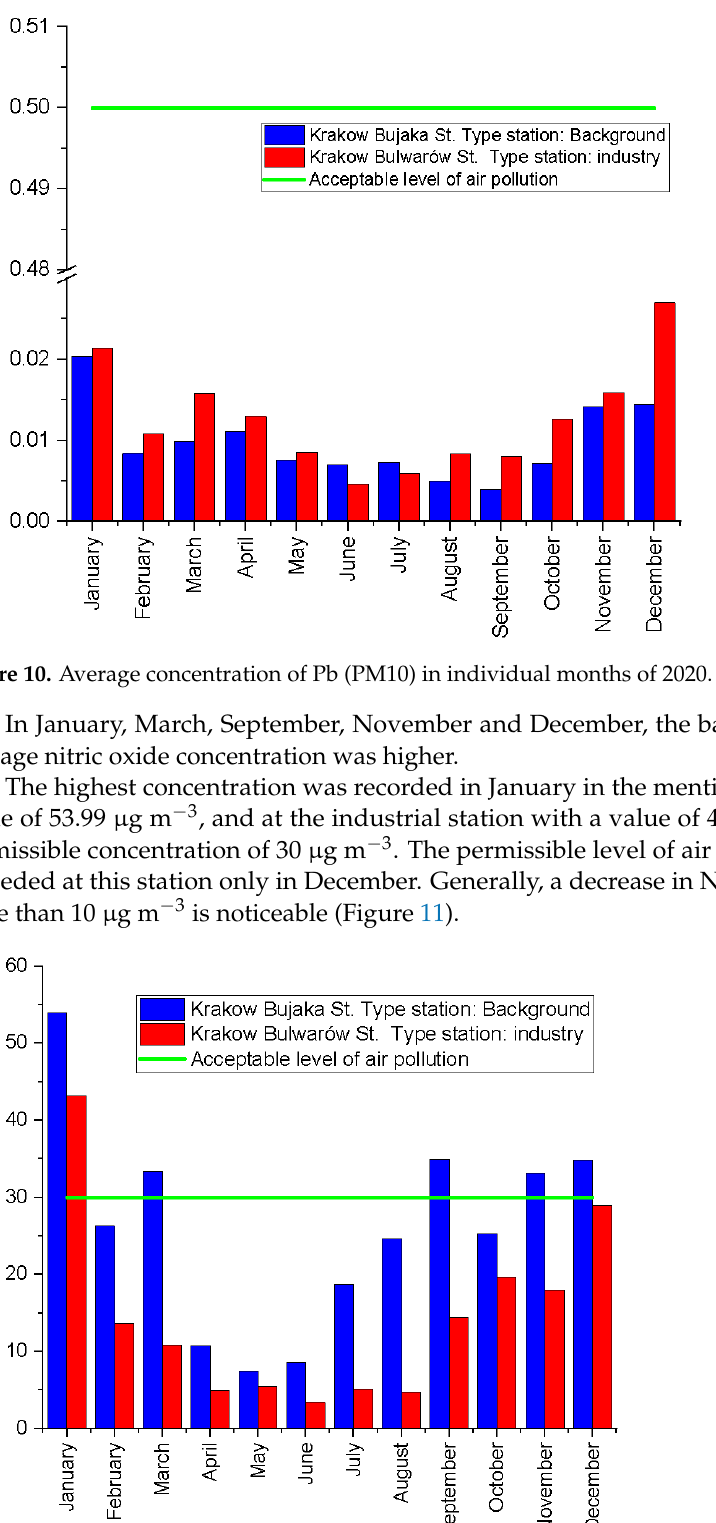
Figure 12. Average NO 2 concentration in individual months of 2020.